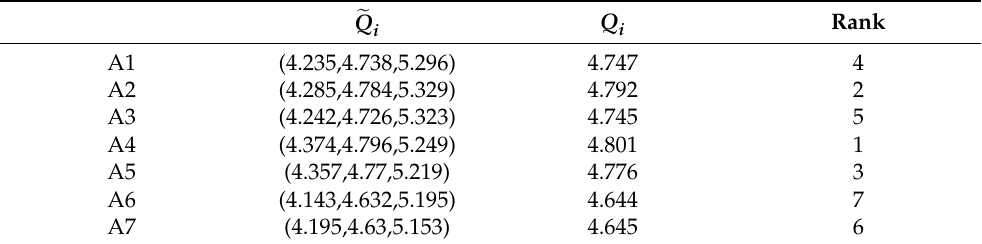
Table 10. Rank of